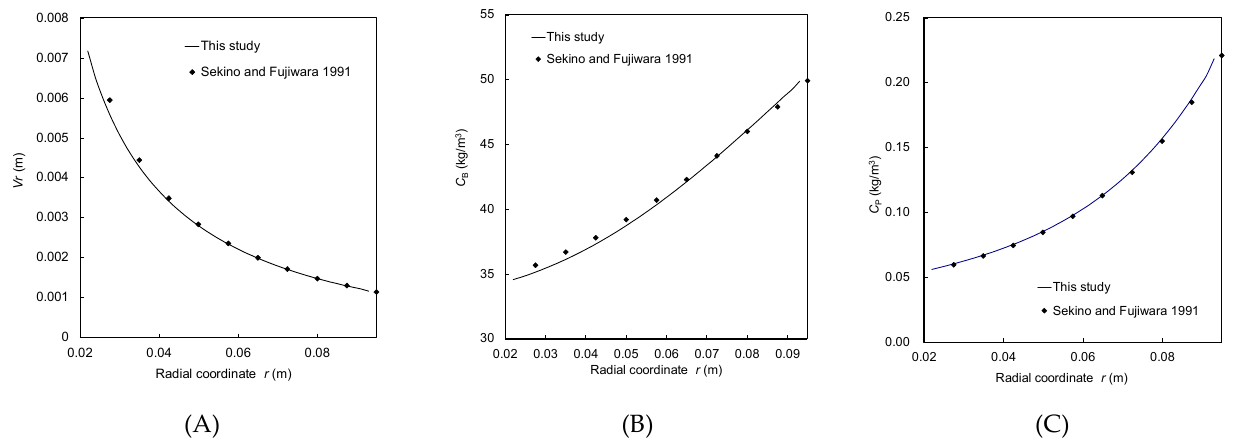
Figure 7. Comparison of the simulation results of radial profile between the conventional FCP model (dots) and CFD/FCP model (lines) for the SOE module configuration at the center of HF bundle. ( A ) The radial flow velocity; ( B ) the salt concentration outside the HF; ( C ) the salt concentration inside the HF for the SOE module configuration.